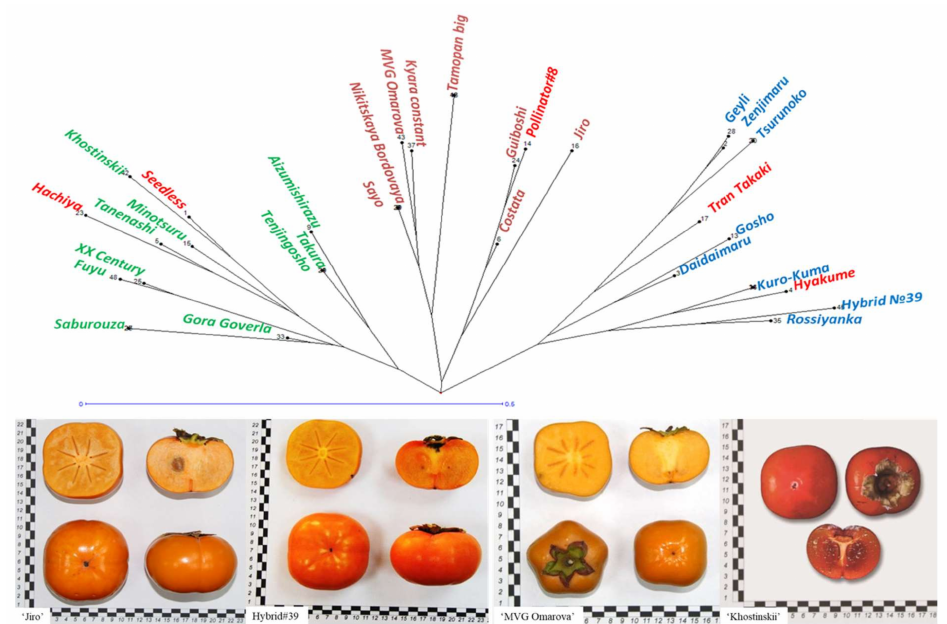
Figure 4. Phenotypical variability and Neighbor-Joining clustering of core D. kaki collection based on the following traits: fruit astringency, fruit size, fruit shape and harvesting period. Red cultivars— placement is not in accordance with molecular